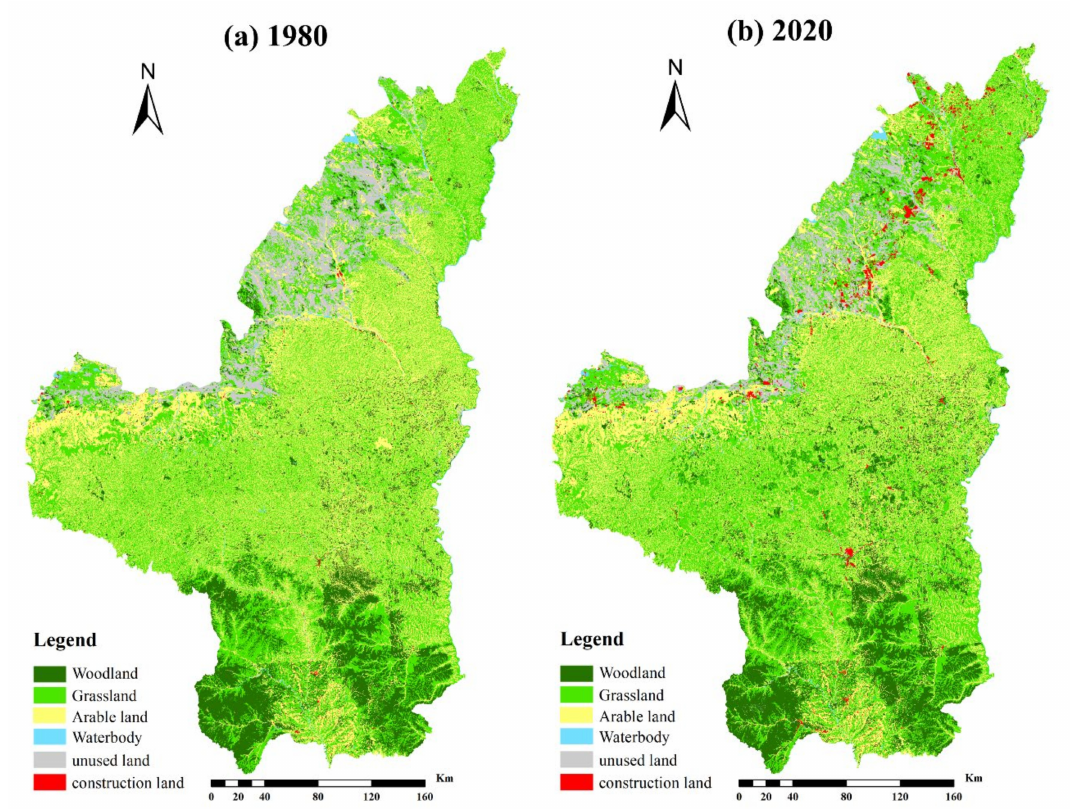
Figure 2. Spatial variations of land-use change from 1980 to 2020.